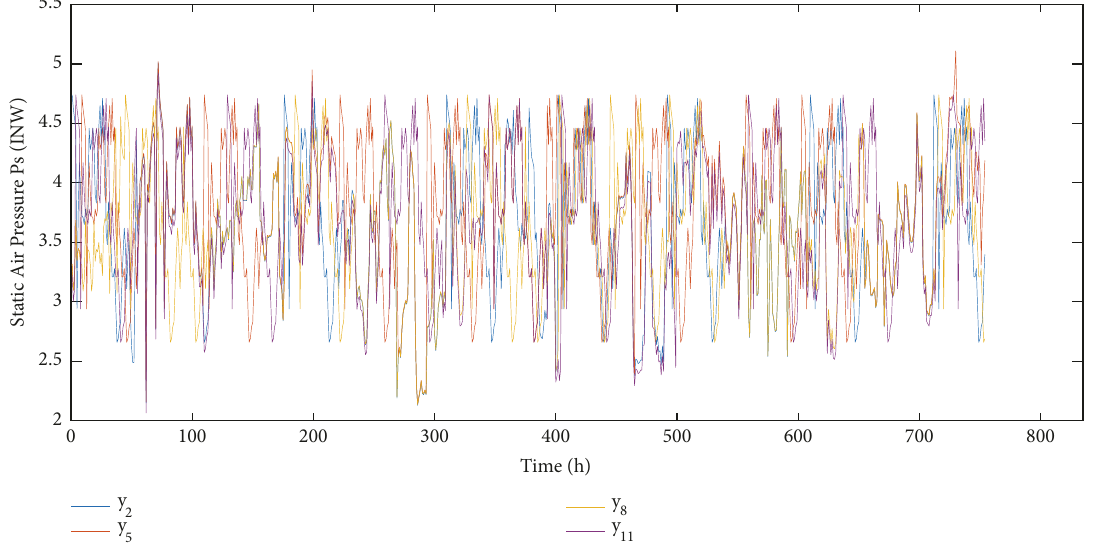
Figure 20: The static air pressure of AHUs.